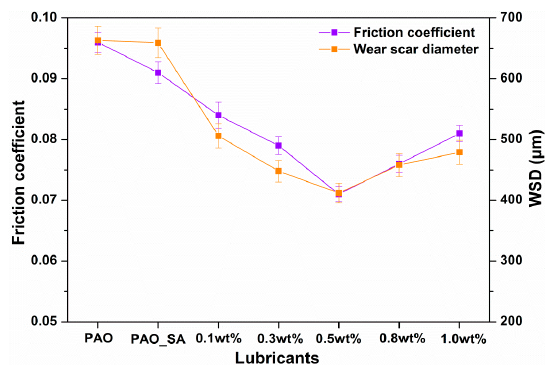
Figure 6. The average friction coe ffi cients and wear scar diameter (WSD) values of varying lubricating samples.